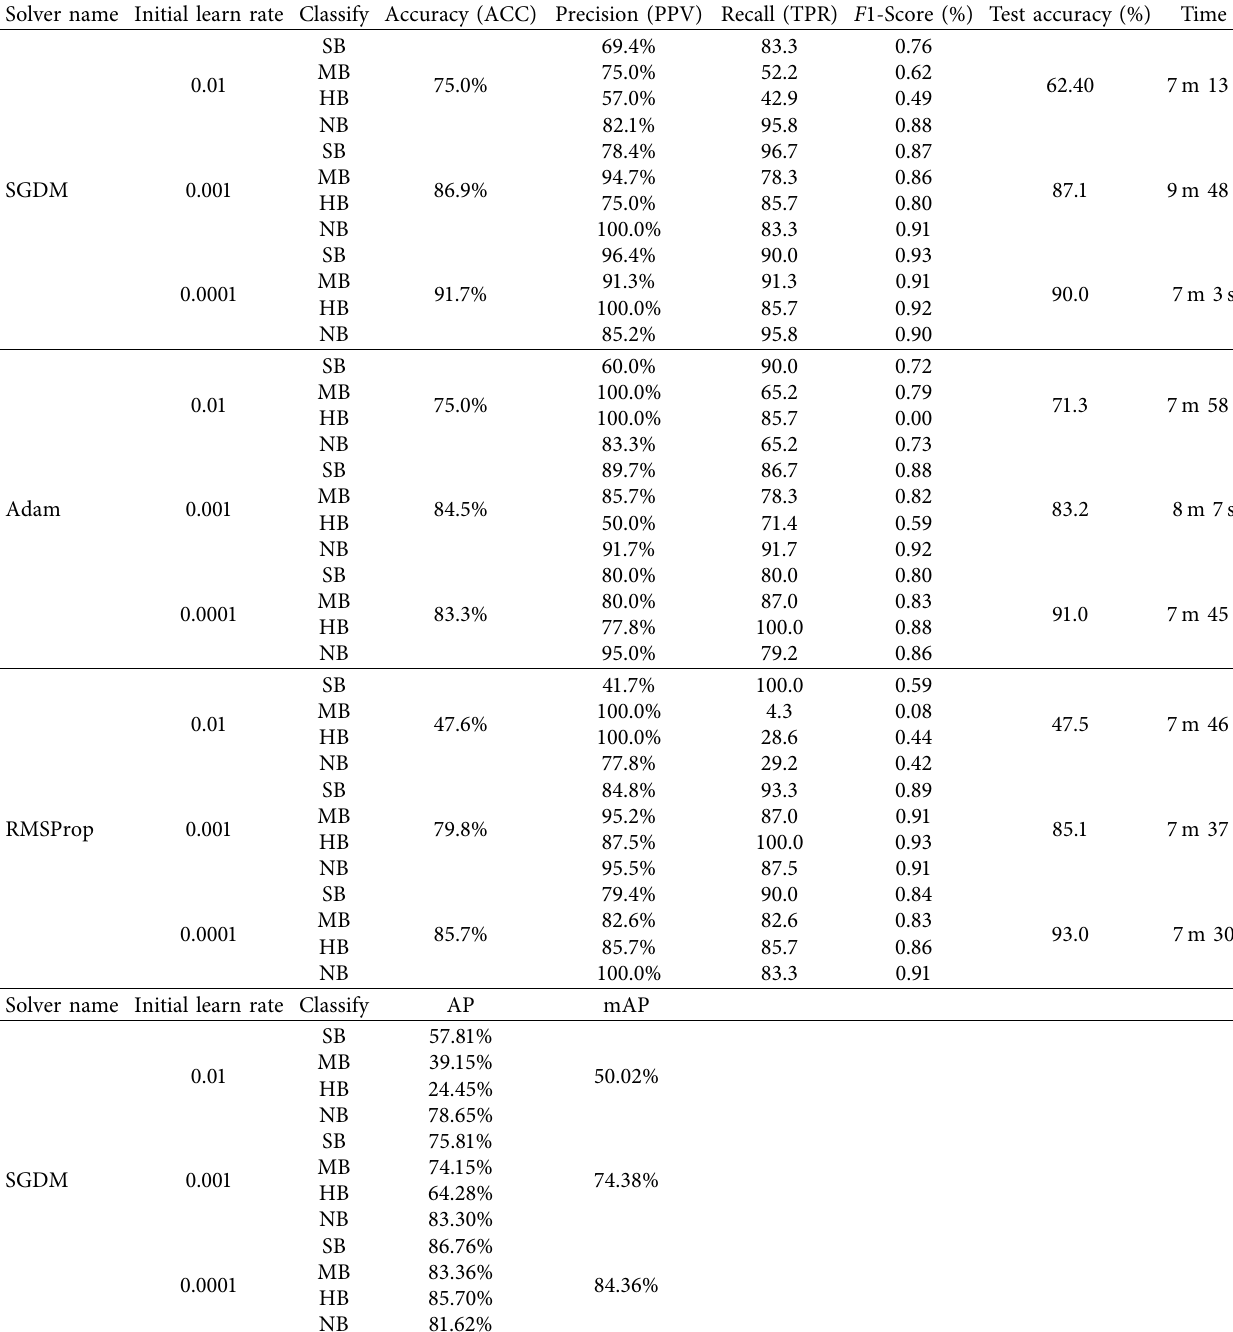
Table 5: ResNet-18 different model parameter